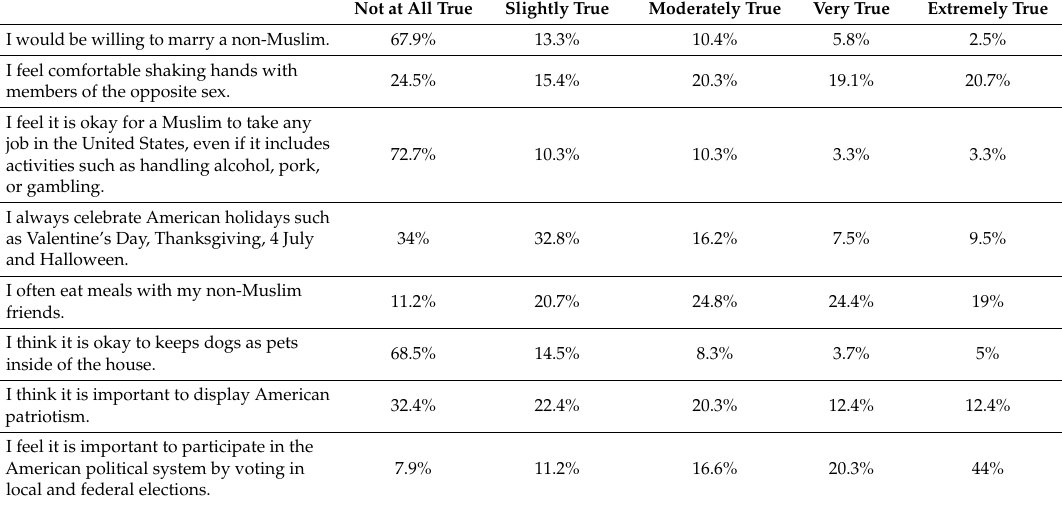
Table 4. Conformity to American Norms. Not at All True Slightly True Moderately True Very True